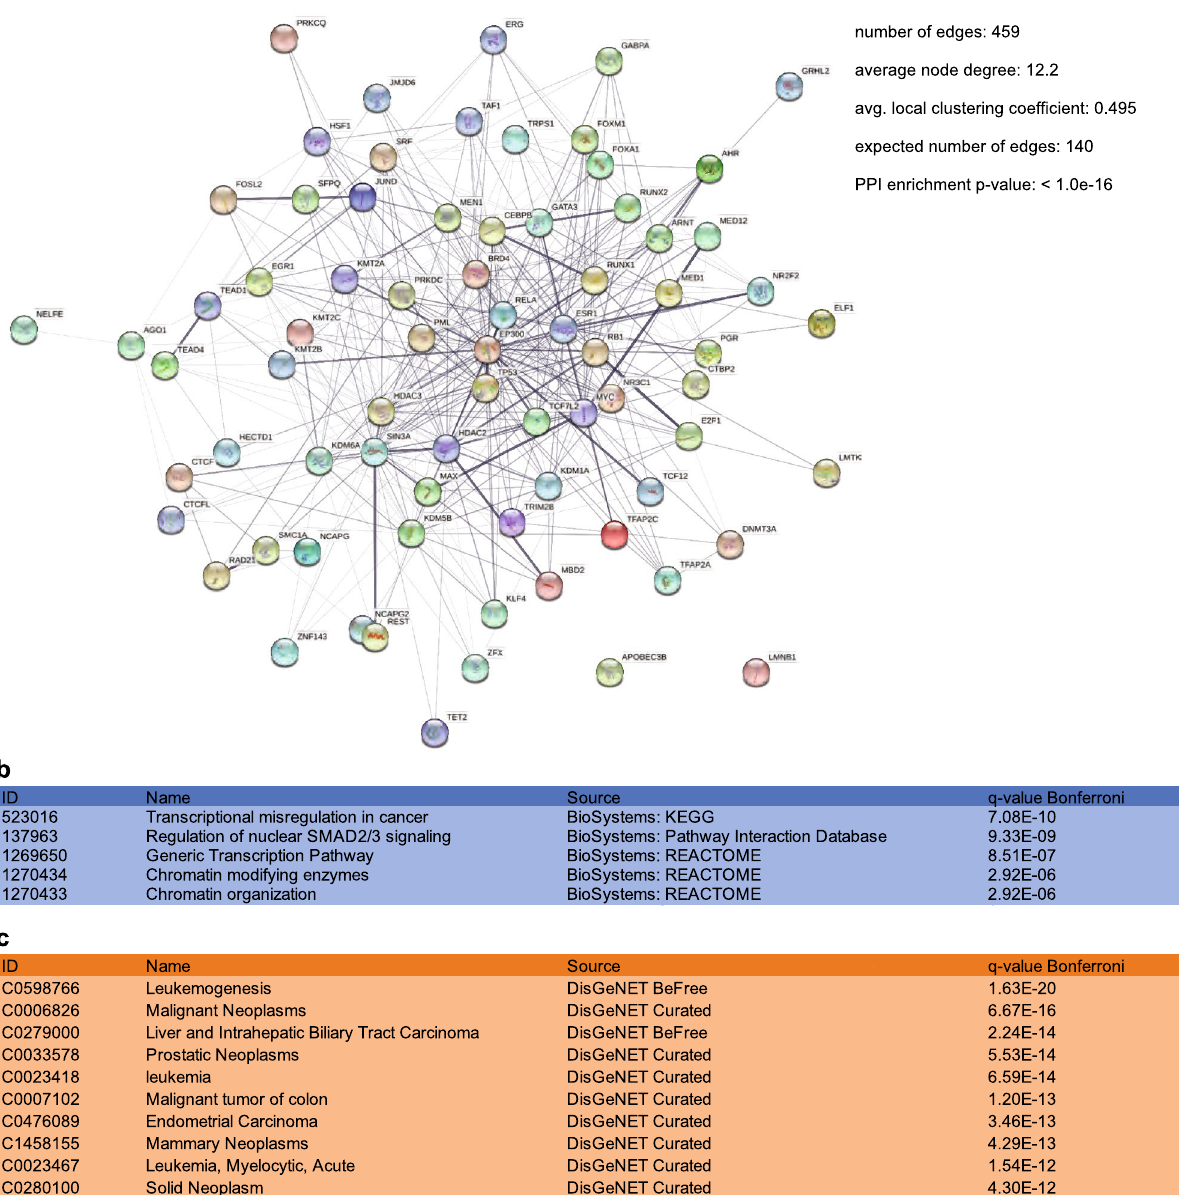
Figure 6. L1PA2 contained binding sites for highly interacting, cancer-associated TF networks in MCF7 cells. ( a ) L1PA2-binding TFs were predicted to form highly interacting networks according to STRING analysis 51 . Edges represent protein–protein interactions with experimental evidence, and the thickness of edges represents level of confidence. Statistical analysis results from STRING are shown. ( b ) Pathway enrichment analysis by ToppFun showed that L1PA2-binding TFs were enriched for transcriptional mis-regulation in cancer 52 . Top enriched pathways are shown. ( c ) Disease enrichment analysis by ToppFun showed that L1PA2-binding TFs were enriched in various cancer types 52 . Top enriched diseases are